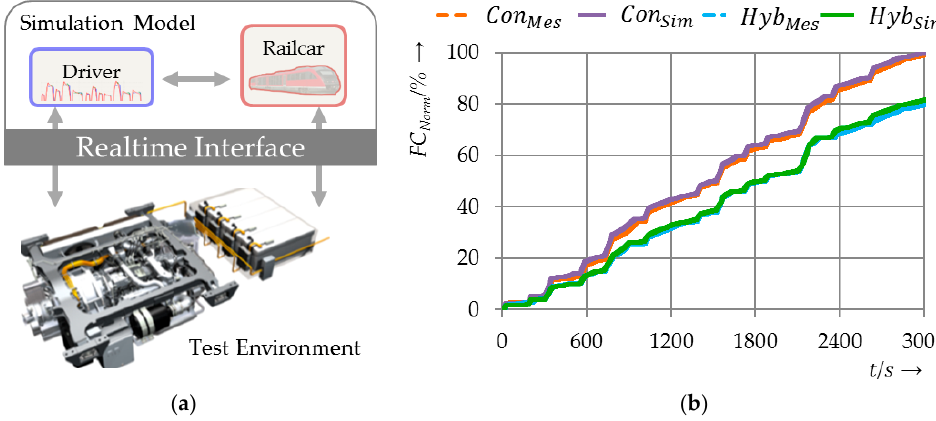
Figure 7. ( a ) Schematic overview over experimental HiL layout; ( b ) Measured and simulated normalized fuel consumption for conventional and hybrid mode.